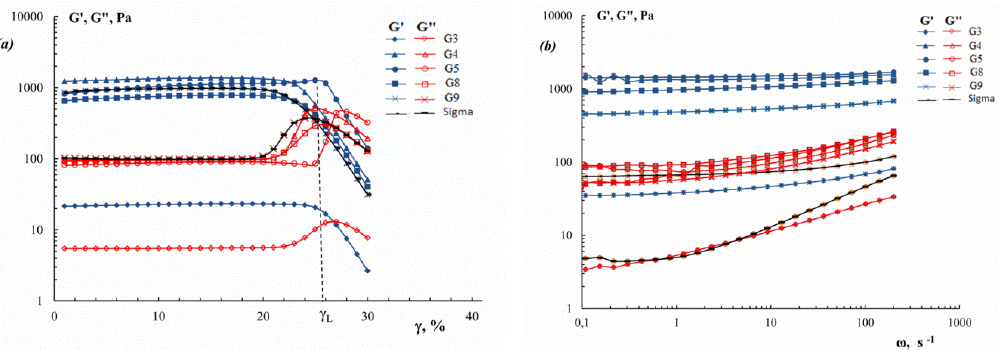
Figure 7. ( a ) Strain amplitude dependencies of the storage modulus G (cid:48) (filled points) and loss modulus G” (open points), ω = 6.28 s − 1 ; ( b ) Frequency dependence of storage modulus G (cid:48) (filled points) and loss modulus G” (open points), γ = 2%, for gels of cod gelatin extracted at di ff erent pH. C G = 10 wt.%, t = 6 °C.